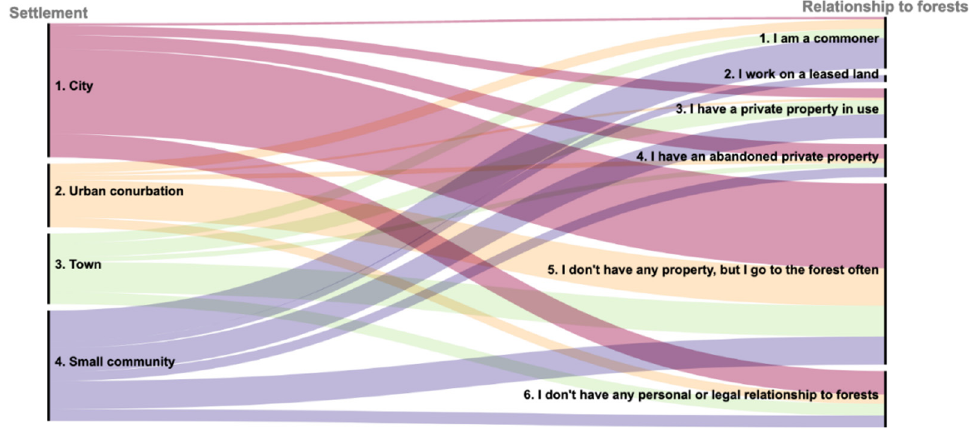
Figure 3. Representation, through an alluvial diagram, of the correlation between the place of resi- dence and the relationships with forests. Figure produced with RawGraphs.